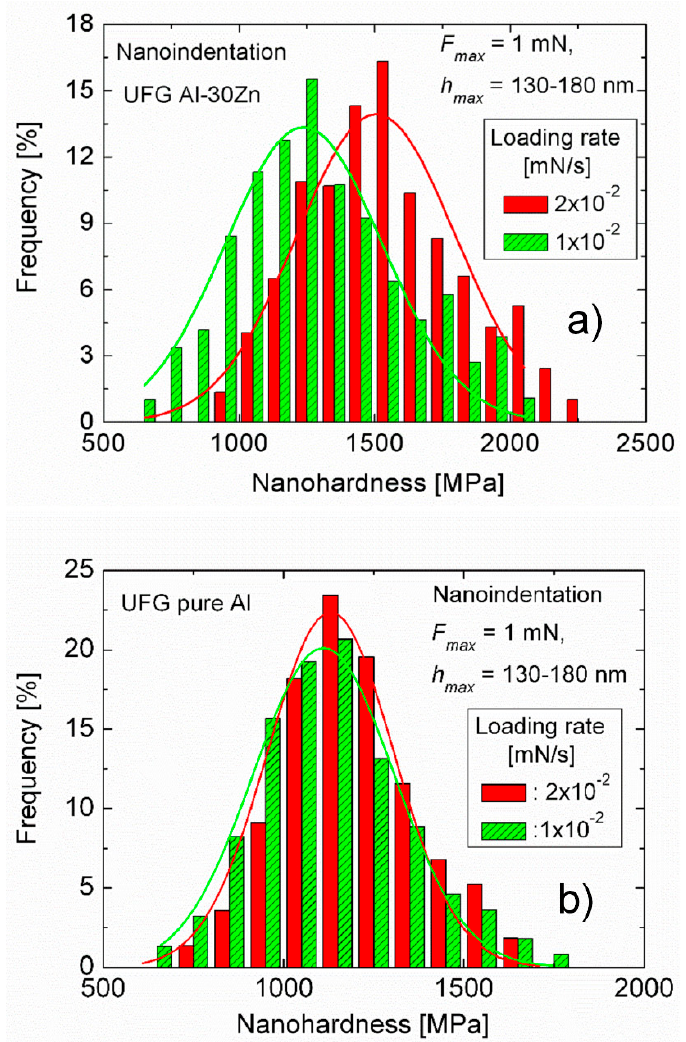
Figure 7. The distribution of nanohardness obtained at the maximum load of 1 mN with two different loading rates on ( a ) UFG Al-30Zn alloy and ( b ) UFG pure Al. The solid lines indicate the Gaussian fit to the distributions, showing the higher SRS of the UFG Al-30Zn sample when a group of several grains is involved in the deformation process. Reproduced with permission from [62]. Copyright 2012, Elsevier.